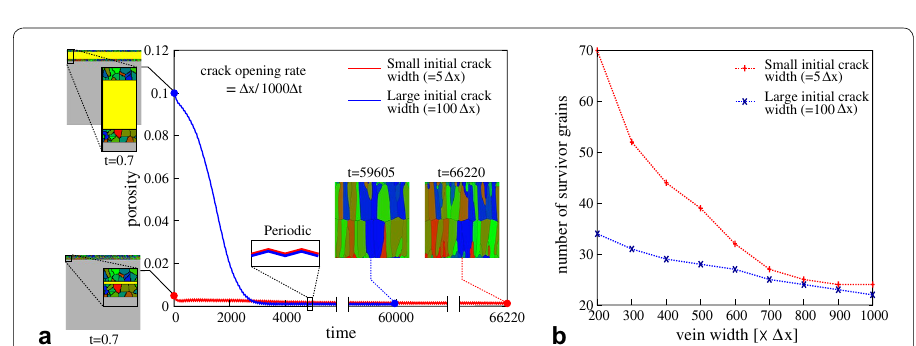
Fig. 6 Simulated bitaxial crystal growth for a initial crack width 100 (cid:31) x (large crack). Progression is shown at representative values of the evolving vein-width (VW). For = small cracks, the resulting veins (at t = 66220 in a ) consist of arrested as well as survivor fibers of different lengths, while large cracks lead to uniform fibrous vein textures (at t = 59605 in b )